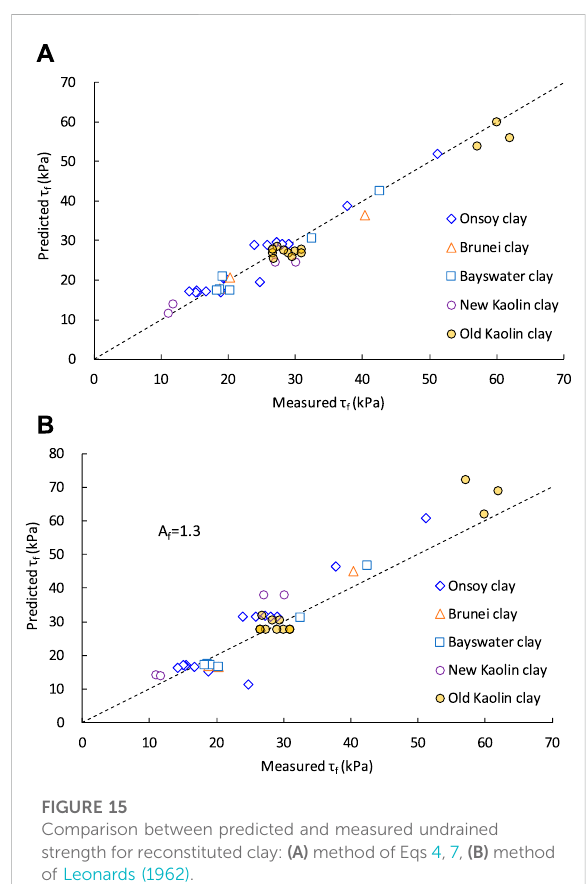
FIGURE 15 Comparison between predicted and measured